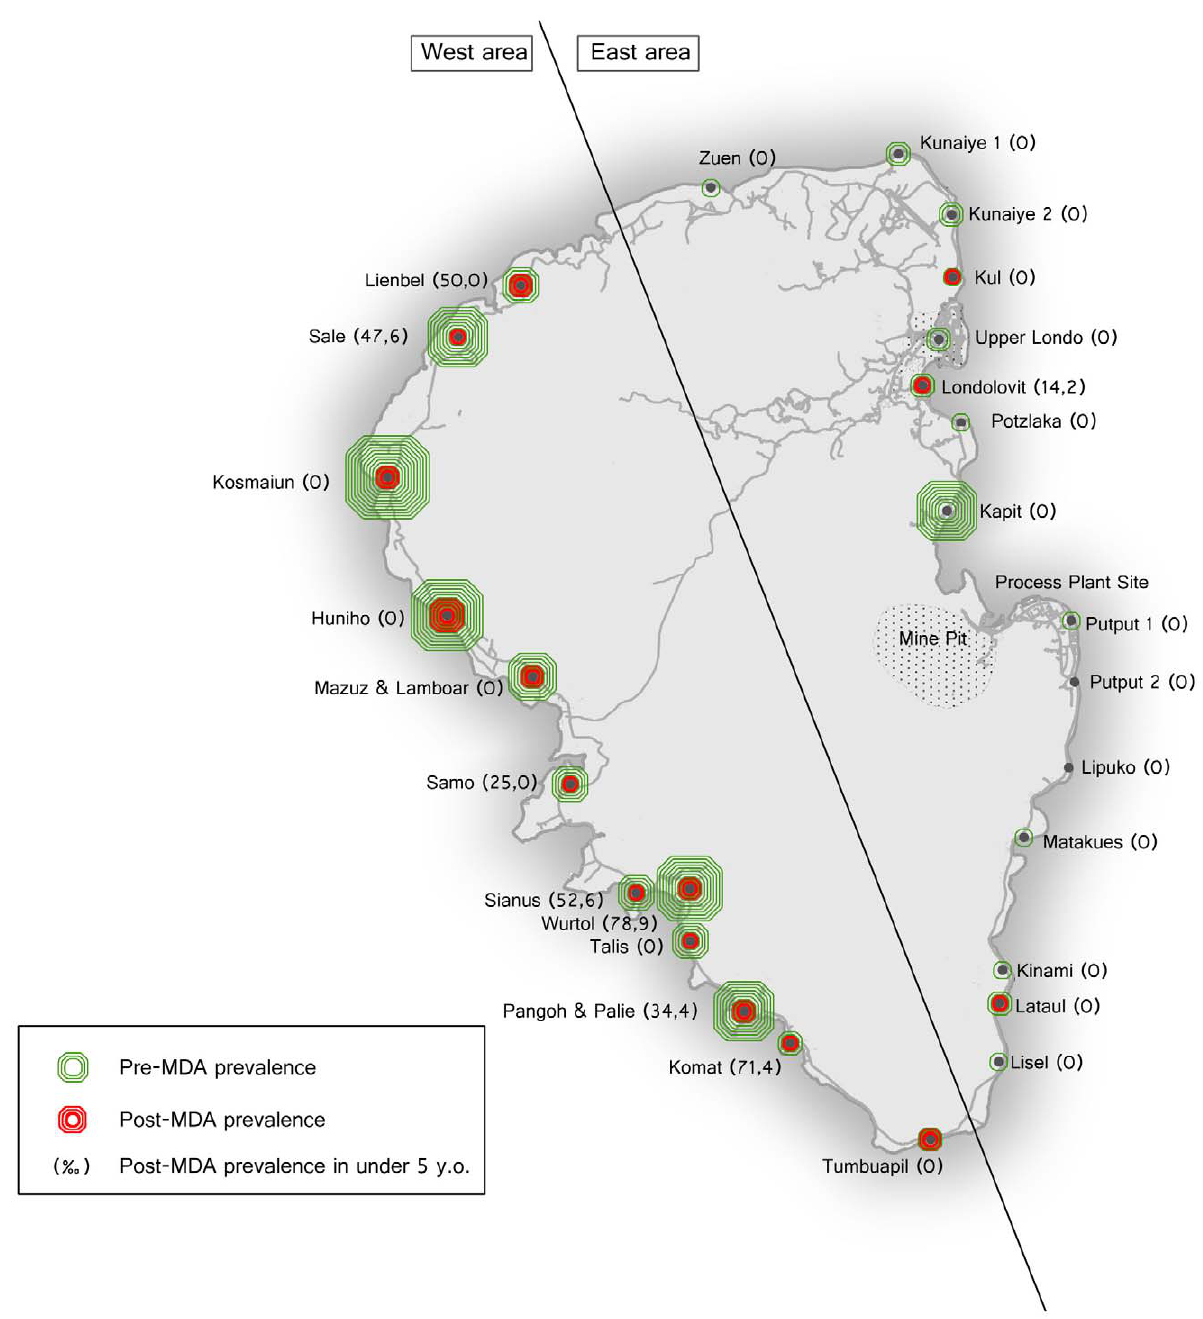
Figure 2. Percentage of Infected people, in Lihir Island Villages, in the pre-MDA and post-MDA surveys. NOTE. The diameter of the circles is proportional to the estimated prevalence of Lymphatic filariasis, implying that every line corresponds to an increase in prevalence of 5%.